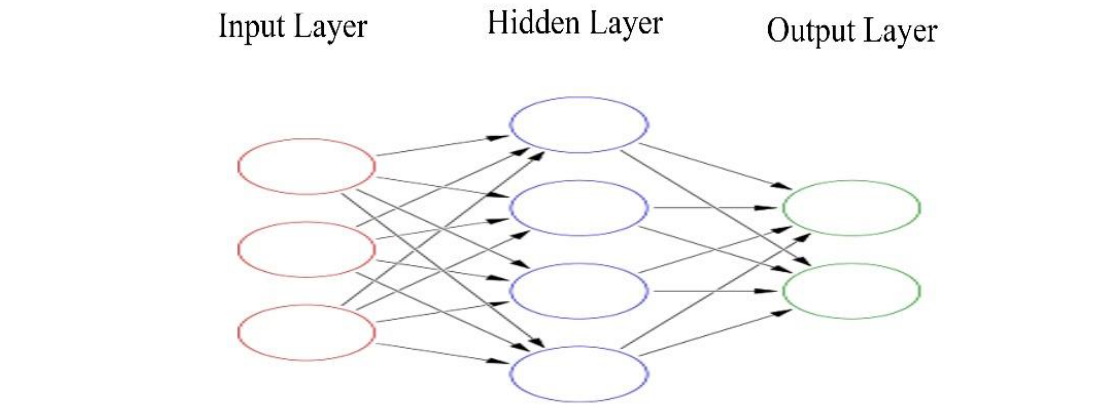
Fig. 2. ANN general